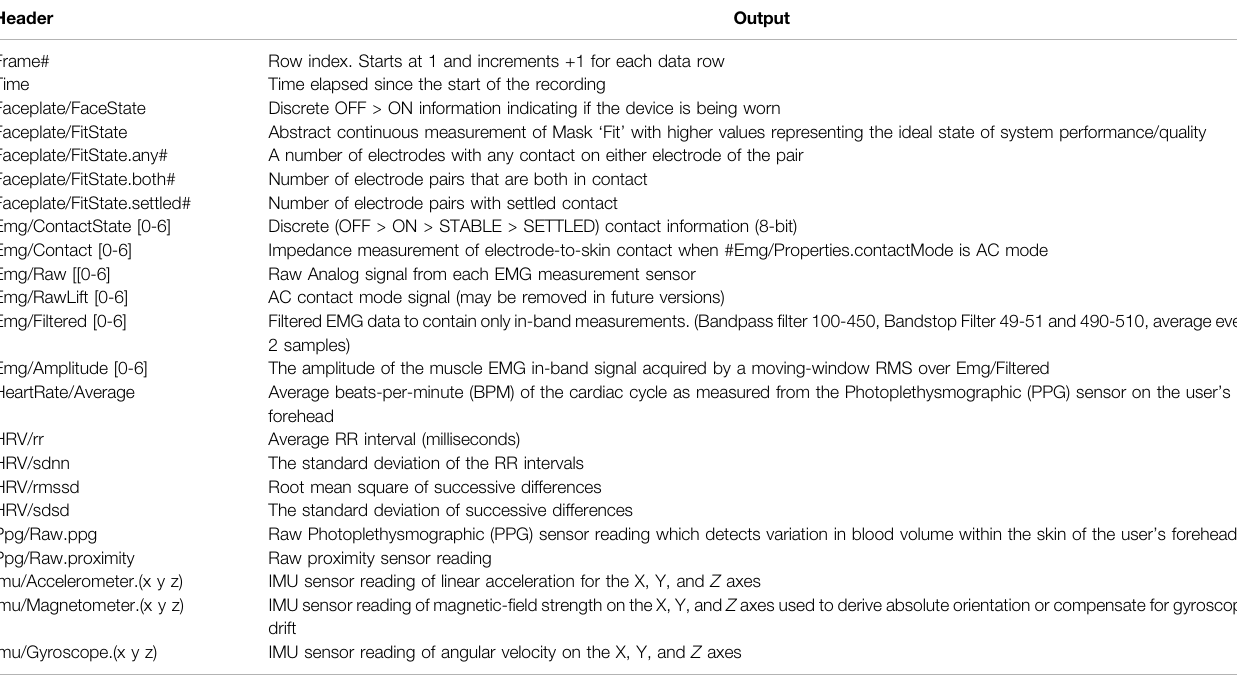
TABLE 1 | List of all available data streams recorded with the emteqPro. Header Frame#